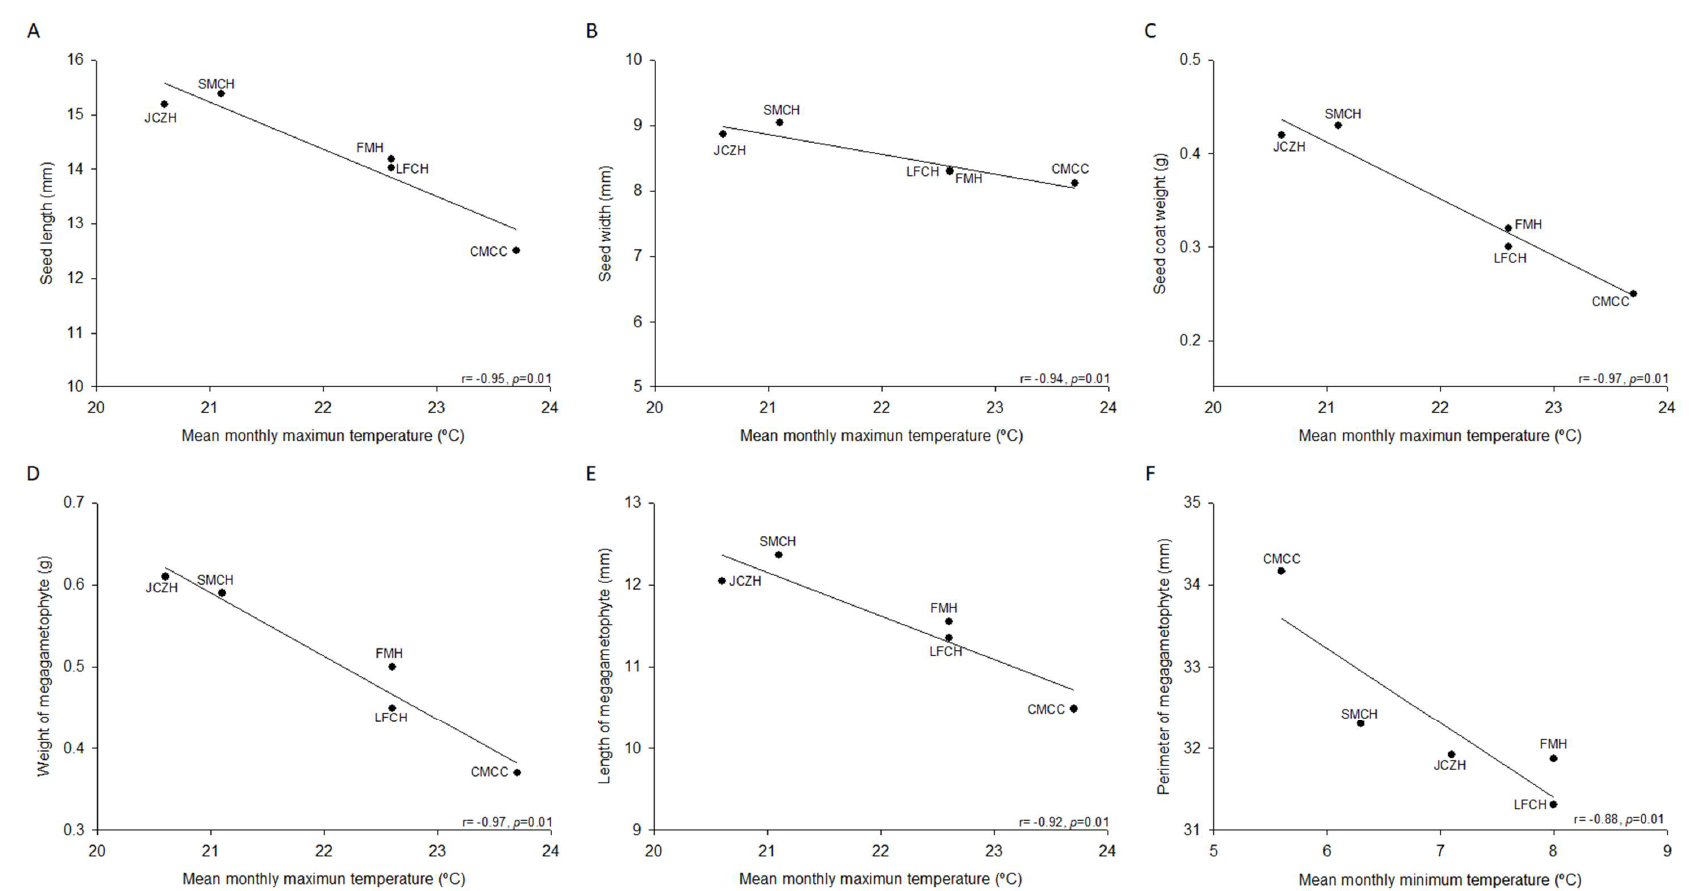
Figure 1. Correlation between morphological characteristics and climatic data. ( A ) Seed length. ( B ) Seed width. ( C ) Seed coat. ( D ) Weight of megagametophyte. ( E ) Length of megagametophyte correlated whit the mean monthly maximum temperature. ( F ) Perimeter of megagametophyte correlated with the mean monthly minimum temperature. Pearson’s correlation coefficient is indicated with a level of significance ( p ≤ 0.05). Population names are indicated in Table 4.